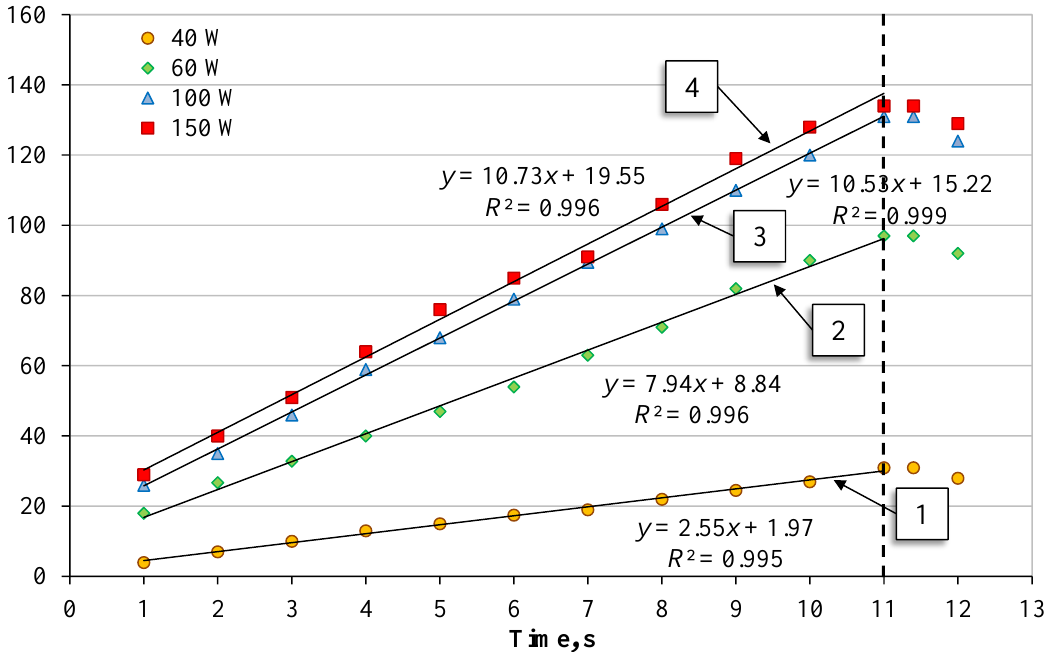
Figure 9. The relationship between the angular velocity of the broad leaved lime ( Tilia platyphyllos Scop ) leaf (active surface area 25.0 ± 1.0 cm 2 ) and the power of heat-emitting source (the length of light source is 11 s): 1 — angular velocity of the leaf with 40 W light source; 2 — 60 W; 3 — 100 W; 4 — 150 W. The dashed line marks the 11 s limit.